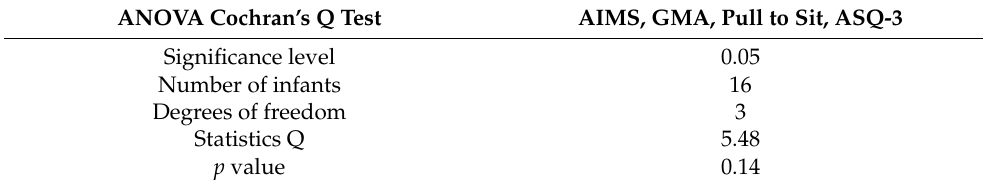
Table 4. Cochran’s Q Test for the AIMS, GMA and pull to sit